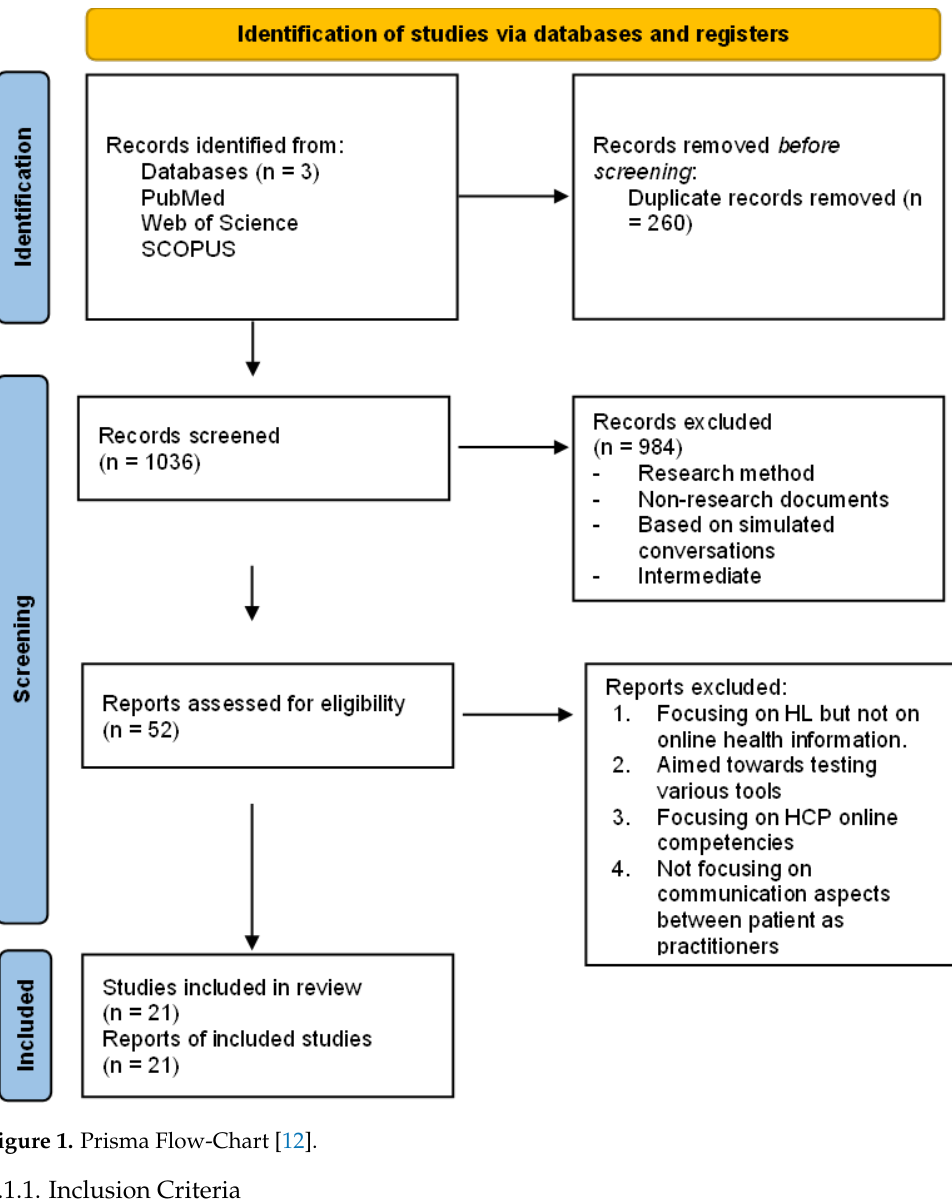
Figure 1. Prisma Flow-Chart [12].